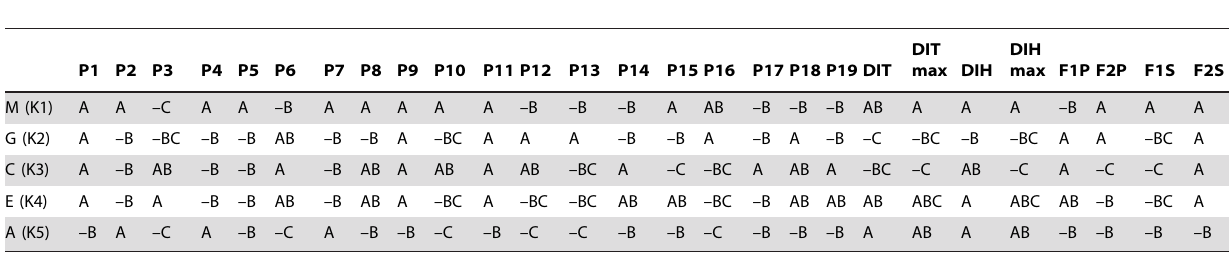
Variable abbreviations: P1–P19: main variables as defined in table 1, DIT: Annual Mean Drought Index (Thornthwaite), DIT, Max: Maximum Drought Index (Thornthwaite), DIH: Annual Mean Drought Index (Hamon), DIH, Max: Maximum Drought Index (Hamon), F1P, F2P: Main two factors for bioclimatic precipitation variables (P12–P19), F1S, F2S: Main two factors for drought-related variables. Kruskal-Wallis tests were applied in all cases except for DI (Drought Index) estimations, where an ANOVA followed by a Tukey’s-b post-hoc test was used. A, B and C are different ranks. Populations with more than one letter could not be assigned to a single rank. Mean for each variable for each population: A . B . C. Bold variables: Drought-related variables. Selected variables for further analysis based on their conceptual power to describe drought